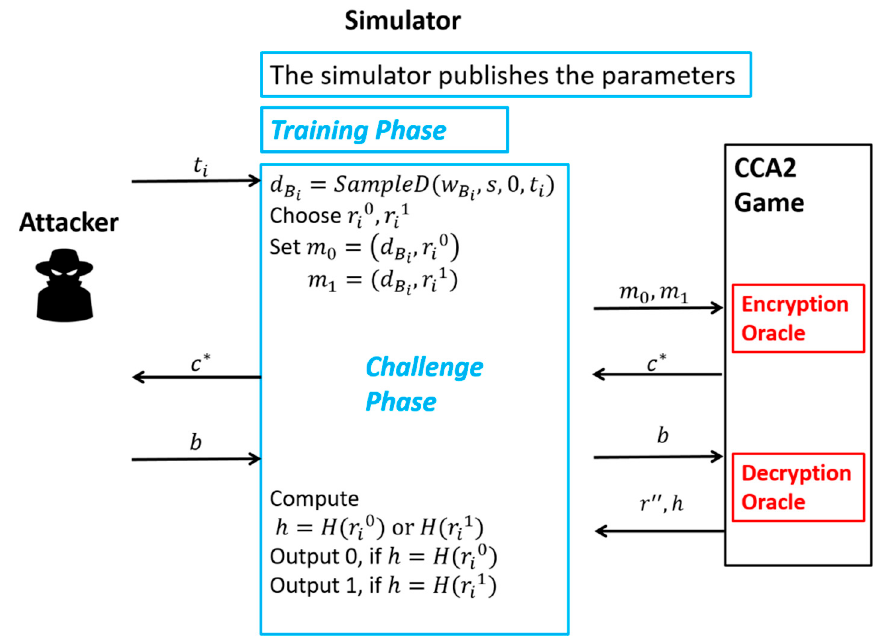
Figure A4. The authenticity of the manager ( Q (cid:48) = 1 ) .